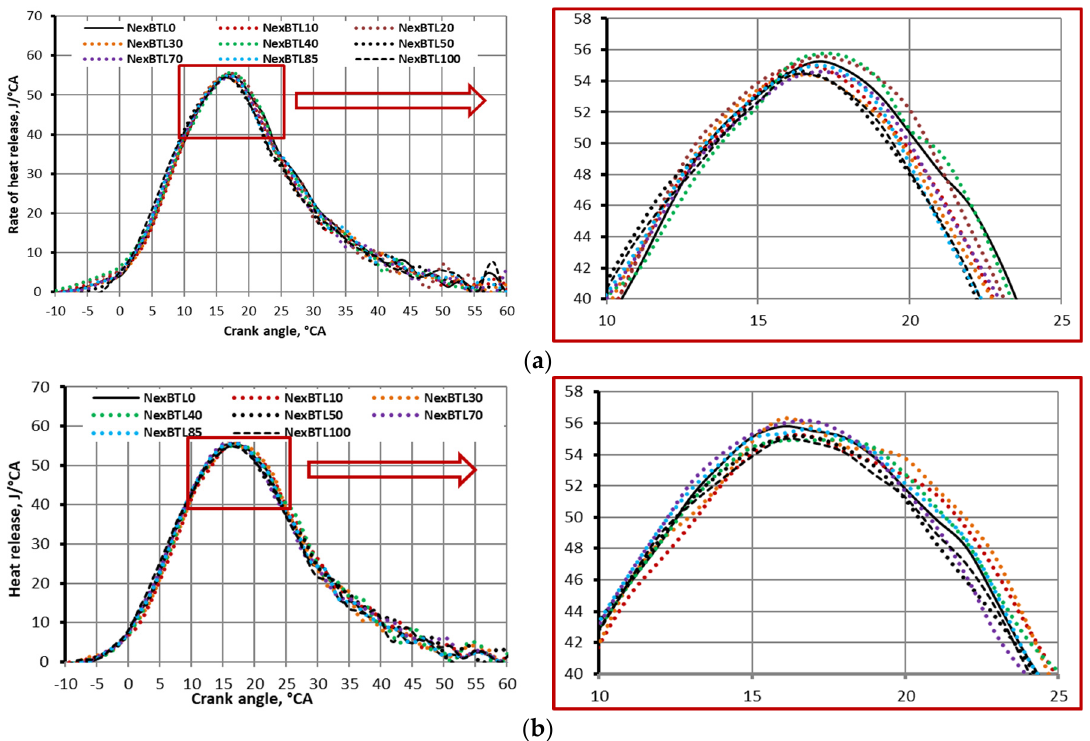
Figure 7. Rate of heat release characteristics: ( a ) n = 2000 rpm, M B = 120 Nm; ( b ) n = 2500 rpm, M B = 120 Nm.